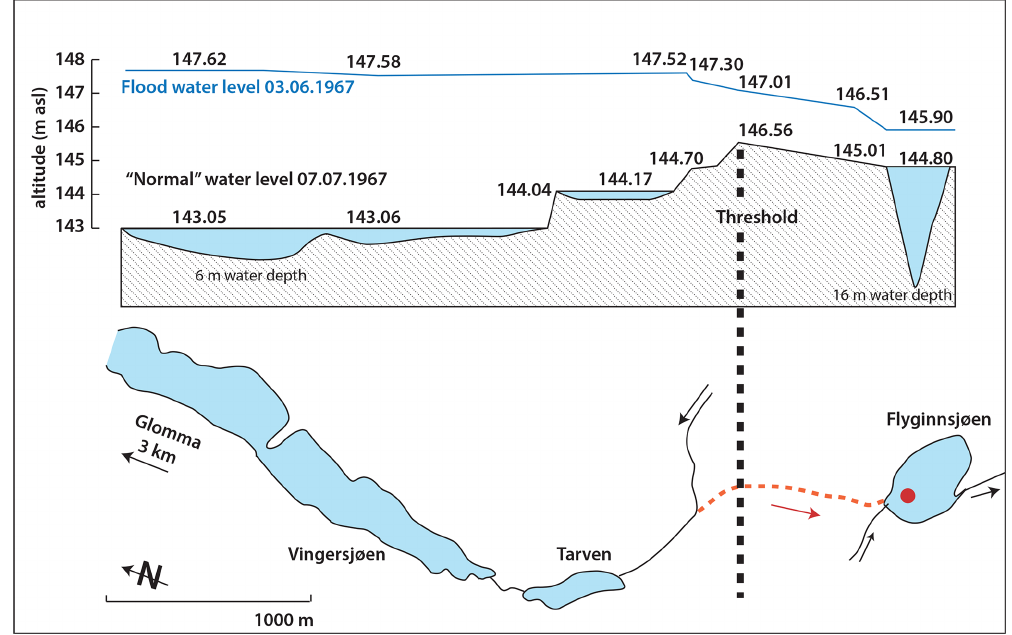
Figure 4. Schematic model of the lakes involved, flood water levels, thresholds, and flood pathways (after Hegge, 1968). The example shows the observed water level exceeding the threshold during the flood in 1967 (2533m 3 s − 1 ) and the normal water level approx. 1 month after the flood event. The dotted red line and arrow show the bifurcation over the threshold, and the red point marks the coring site in Flyginnsjøen. Note that the inlet during bifurcation events is only around 30m away from the permanent inlet. Table 2. Information about large historical floods at